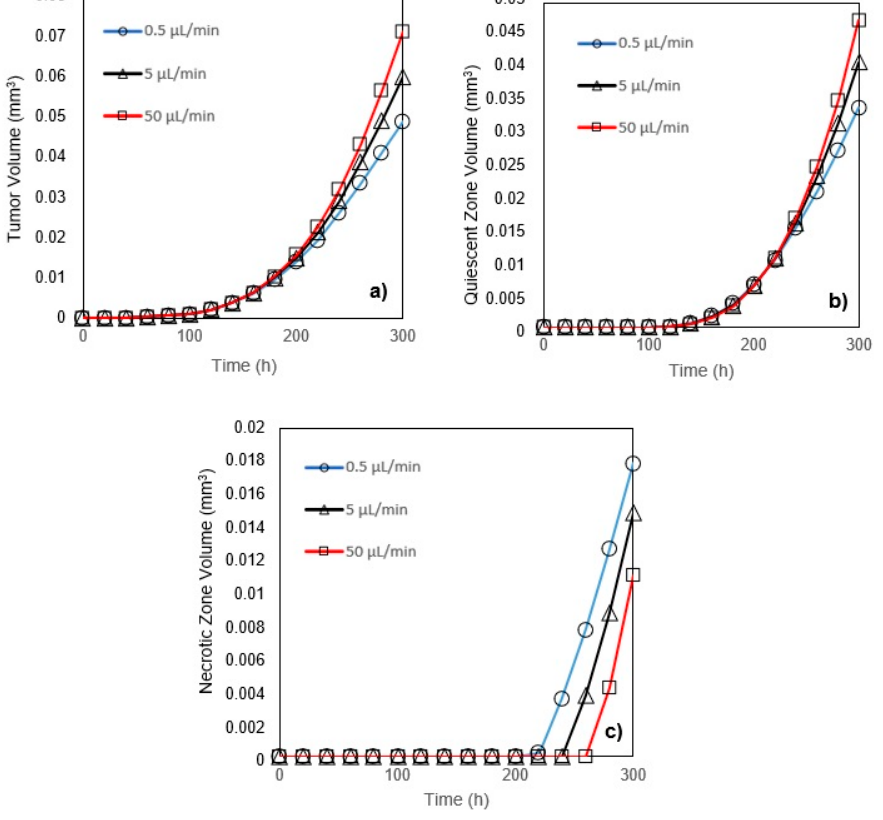
Figure 6. ( a ) Tumor volume; ( b ) Quiescent zone volume; ( c ) Necrotic zone volume for three inlet flows (0.5, 5, and 50 µ L / min) versus time (glucose and oxygen concentration at the inlet are respectively 0.8 mM and 0.28 mM). The initial radius of the tumors in both of the traps is 24.3 µ m.